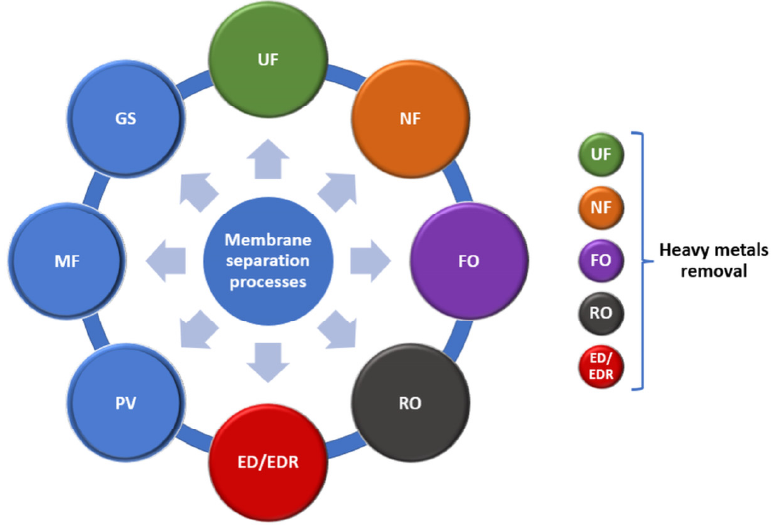
Figure 2. Separation processes carried out by membrane processes, with emphasis on those involved in heavy metals removal.